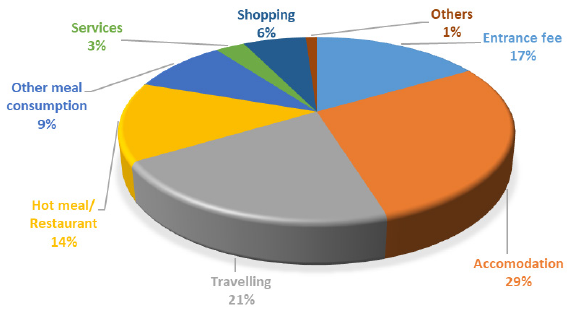
Figure 3. Distribution of foreign spectators’ expenditure